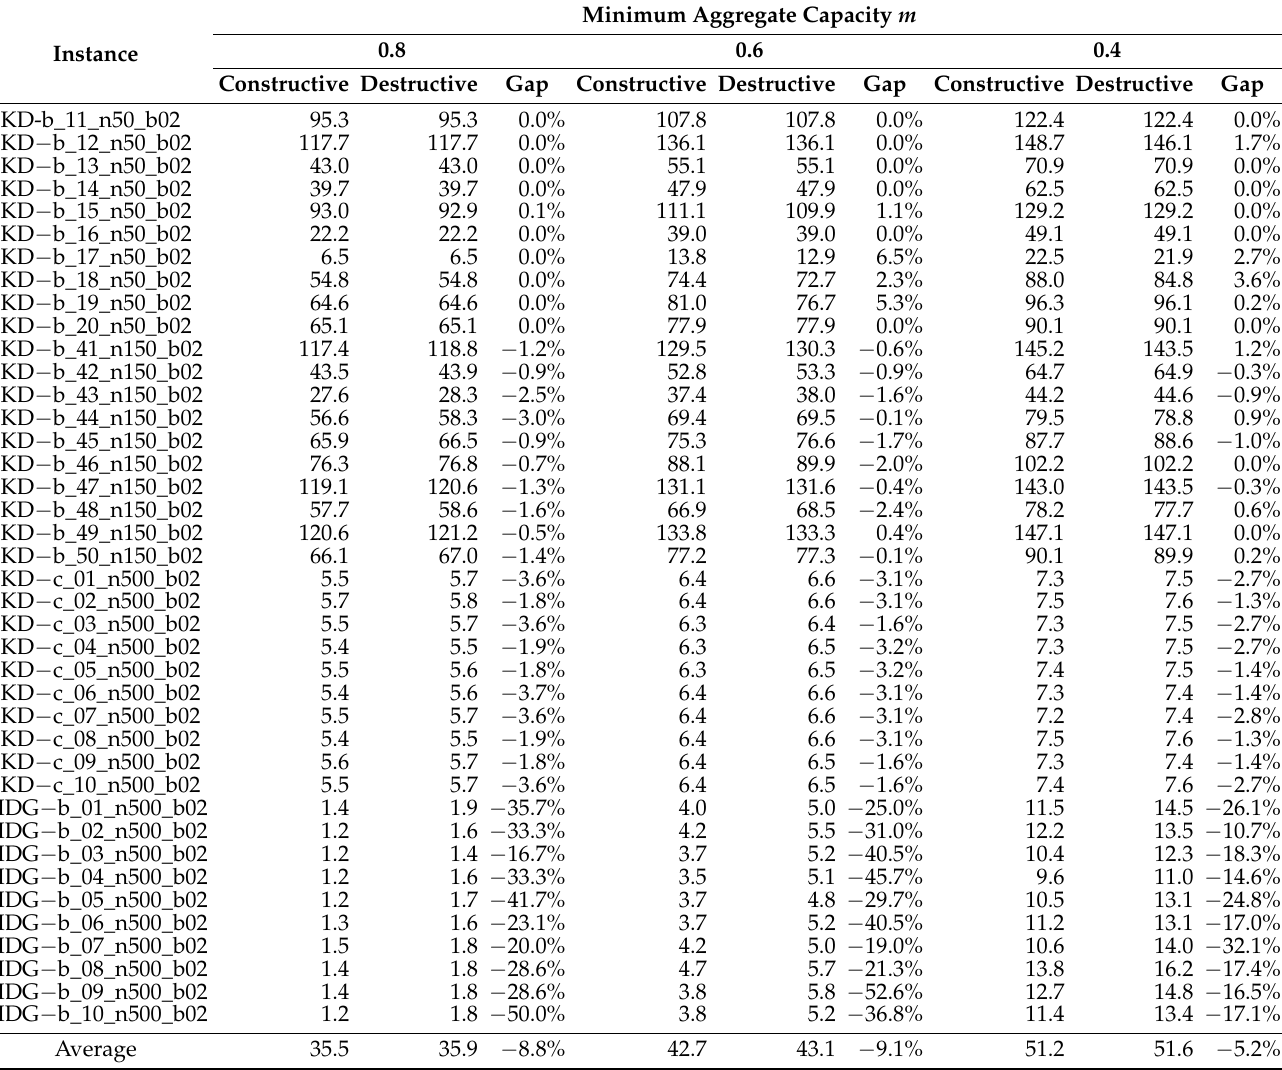
Table 2. Performance of our algorithm versions for different capacity